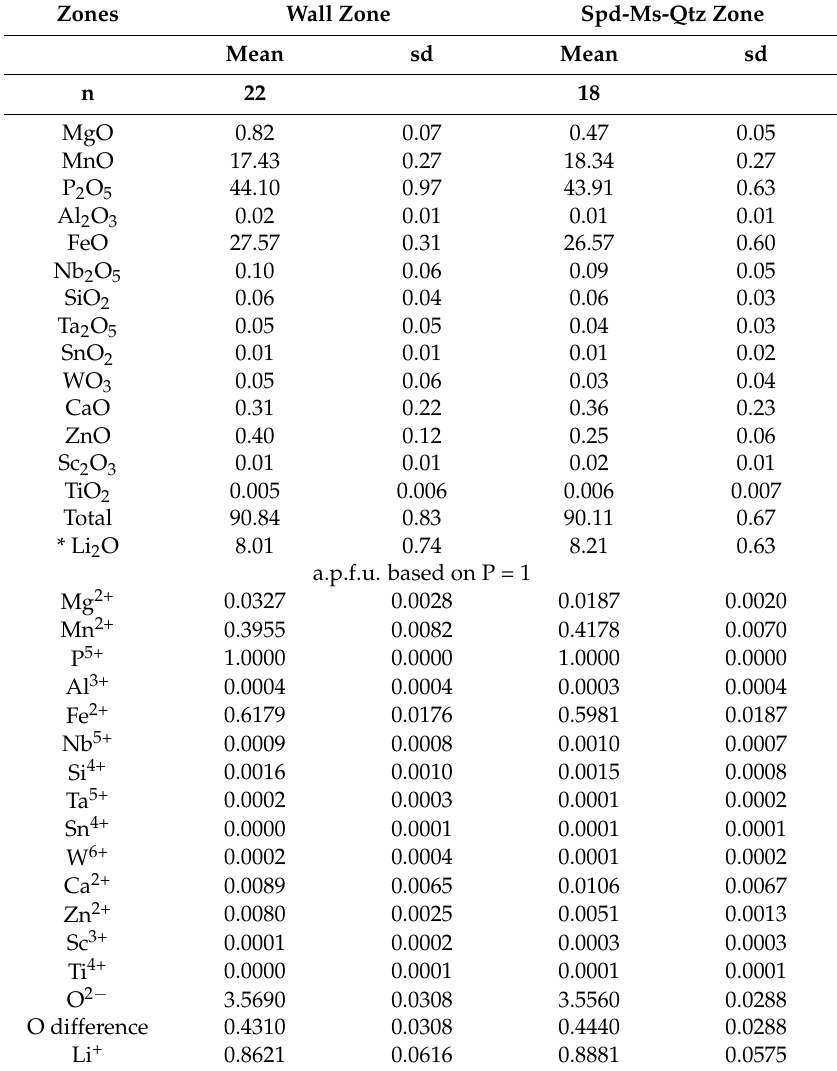
Table 3. Representative compositions (wt. % oxides and a.p.f.u.) of triphylite-lithiophilite series (Li(Fe,Mn)PO 4 ) from No. 90 albite-spodumene